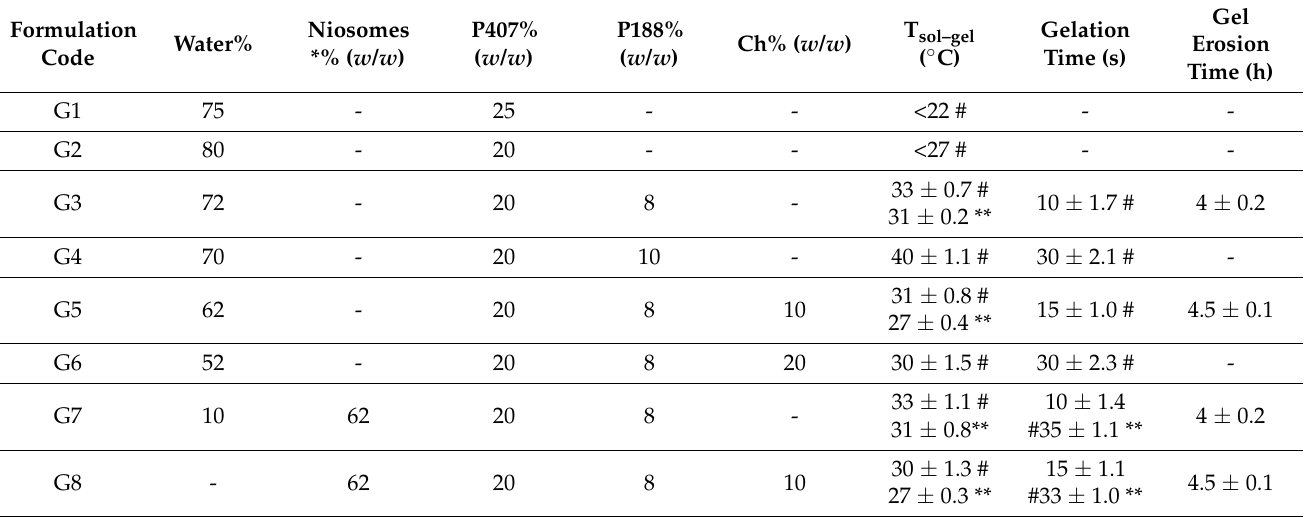
Table 2. Composition and gelation properties of plain and hybrid niosomal in situ